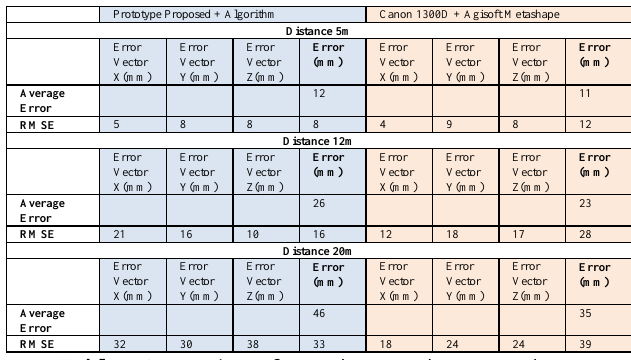
39 Table 1. Comparison of errors between the proposed system and the classical photogrammetry methodology, measured with control points.